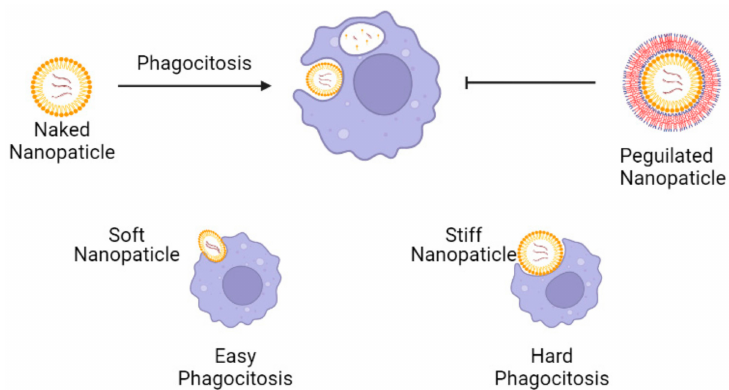
Figure 5. Nanoparticles containing siRNA and the strategies to evade phagocytosis. Nanoparticles coated with non-ionic hydrophilic polymers, as well as PEG (PEGylated nanoparticles) can evade phagocytic cells given the diminished adsorption of opsonin. Soft nanoparticles are more likely to be engulfed, given the ability of cells to deform nano capsules. Created with